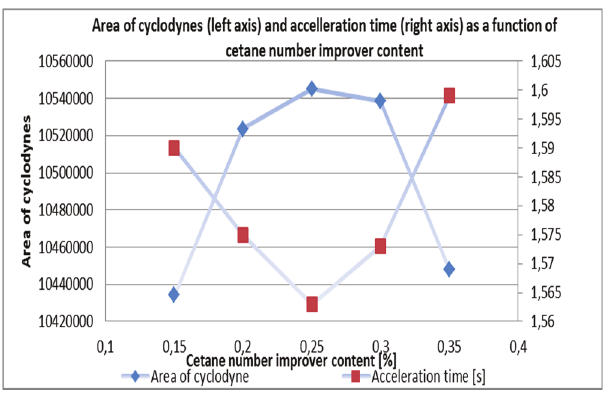
Fig. 4. Area of cyclodyne (left axis) and acceleration time (right axis) as a function of cetane number improver